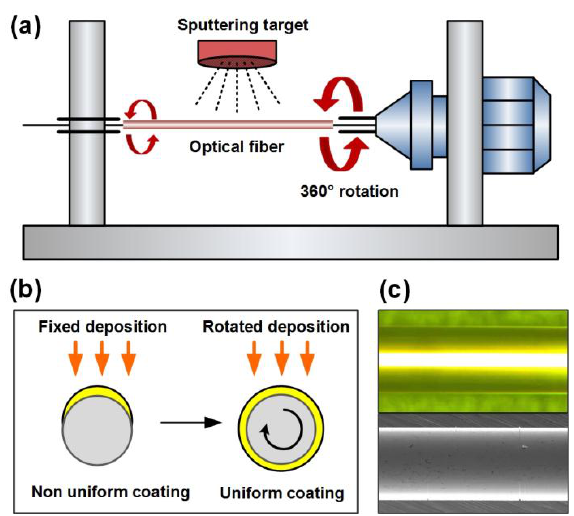
Figure 8. ( a ) Sketch of the sputtering (or vacuum evaporation) deposition process to obtain a uniform metal thickness all around the optical fiber cross-section; ( b ) principle of the double deposition process; and ( c ) microscope view of a gold-coated fiber surface.